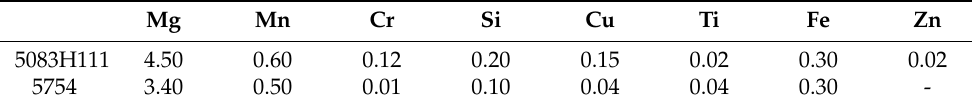
Table 1. Main chemical composition of two aluminum alloys (%).